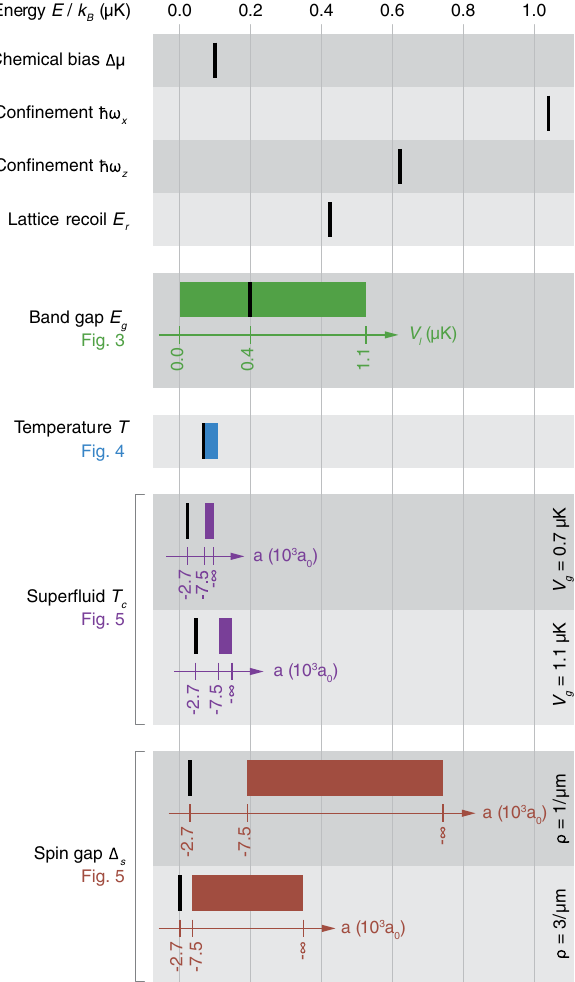
FIG. 6. Summary of the energy and temperature scales relevant for the quantum wire. Typical values are indicated by black lines, whereas energies depending on a parameter scanned in Figs. 3 – 5 are represented by colored ranges. The superfluid critical temper- ature T in the vicinity of the wire increases with gate potential V , c g 0 . 7 and 1 . 1 μ K and is reported here for two values V g ¼ corresponding to the conductance onset and gap with a lattice, respectively. The 1D spin gap Δ at the center of thewire decreases s with the 1D density ρ , and is reported here for two values corresponding to a lattice filling of one and three particles per